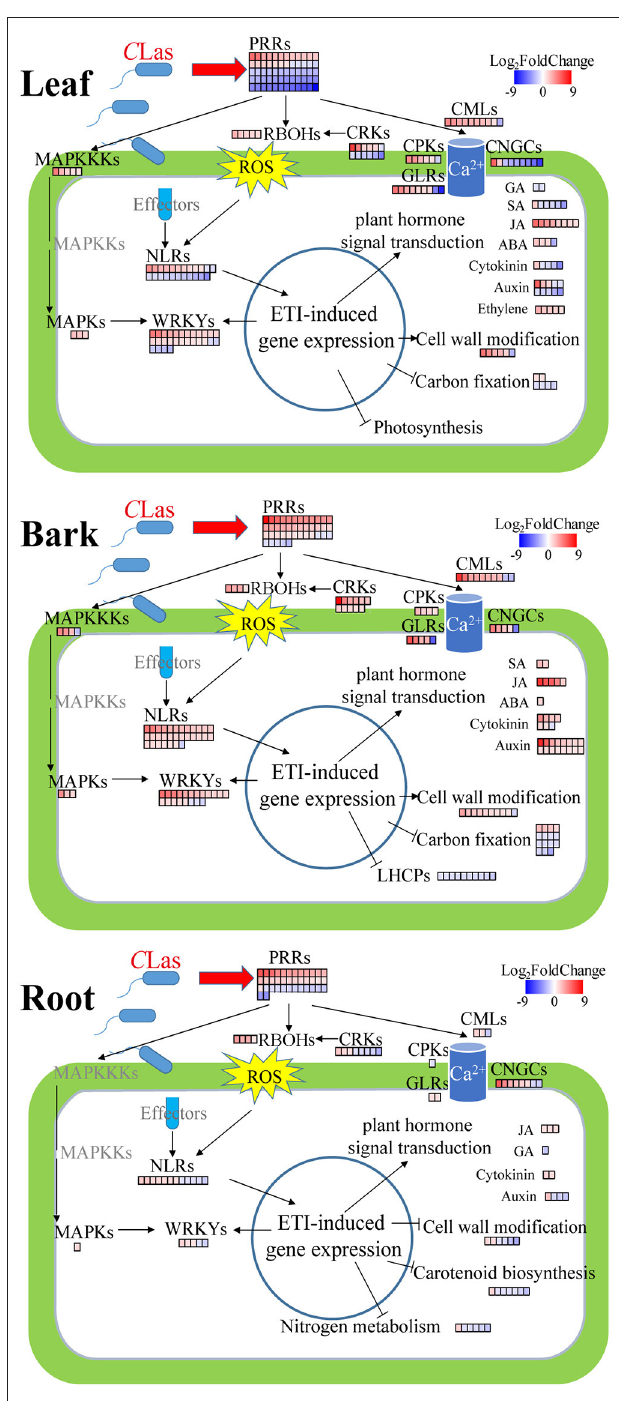
FIGURE 6 | Summary of defense-related DEGs in C Las-infected leaves, barks, and roots. Red, upregulation; blue, downregulation. PRRs, pattern recognition receptors; RBOHs, plant respiratory burst oxidase homologs; ROS, reactive oxygen species; MAPKKKs, mitogen-activated protein kinase kinase kinases; MAPKs, mitogen-activated protein kinases; CMLs, calmodulin-like proteins; CPKs, calcium-dependent protein kinases; CNGCs, cyclic nucleotide-gated channels; CRKs, cysteine-rich receptor-like kinases;